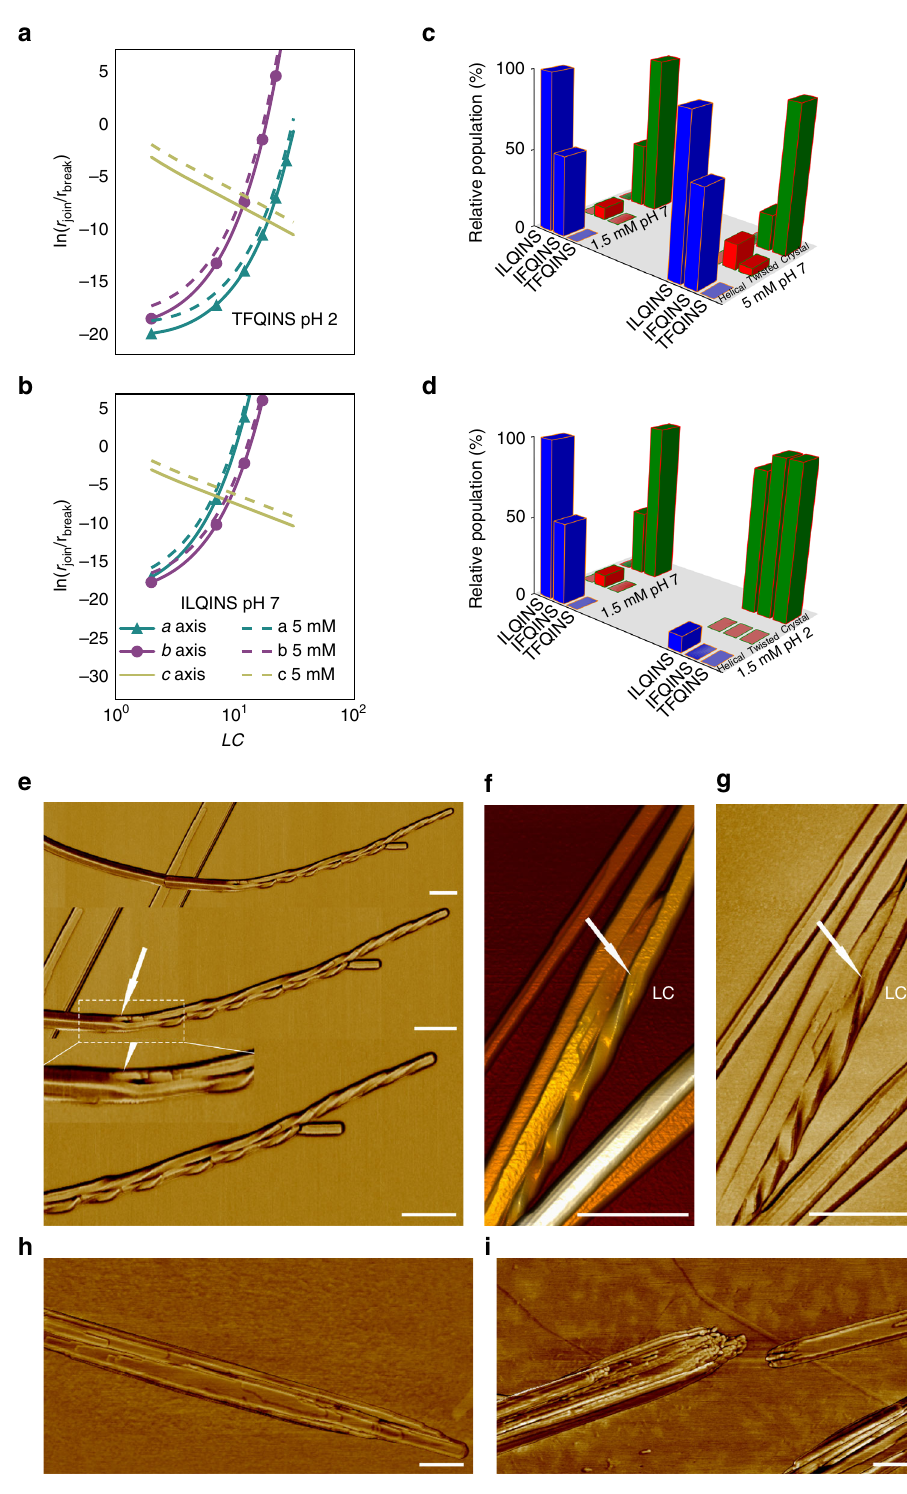
Fig. 5 Theoretical and experimental proof that increased peptide concentration reduces crystal formation. Analytical rate calculations for a TFQINS at pH 2 and b ILQINS at pH 7 showing the ratio of forward and backward rates of assembly against increasing length in the (initially dominant) c direction. c , d Compare the composition of polymorphs observed experimentally (by AFM) for the three peptides, c shows the effect of varying concentration at pH 7, and d shows the effect of varying pH at 1.5 mM. e AFM phase images of TFQINS deposited on mica self-assembled at pH 7 (5 mM) for 24 h showing splitting of crystal into two twisted fi brils. AFM 3D image f and AFM phase images g of TFQINS deposited on mica self-assembled at pH 7 (5 mM) for 24 h showing fi bril-crystal transformation. AFM phase image of TFQINS deposited on h mica and i HOPG self-assembled at pH 7 (5 mM) for 24 h showing lateral aggregation (scale bar = 200